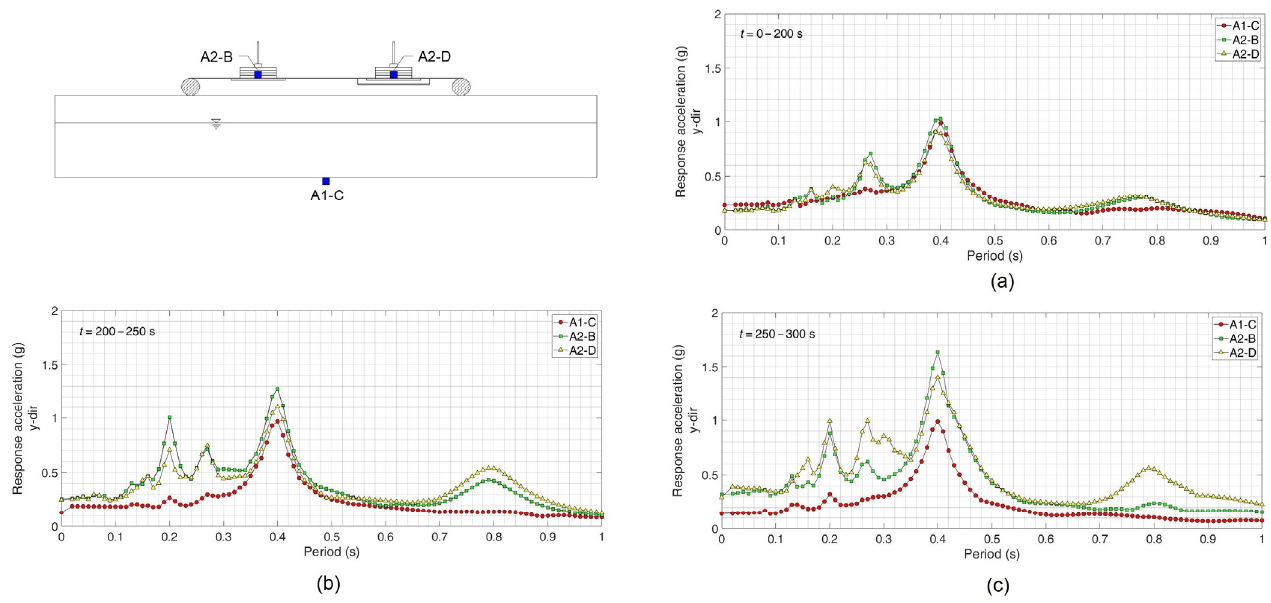
Figure 18. Variation of vertical elastic response spectra: ( a ) t = 0–150 s, ( b ) t = 150–200 s, and ( c ) t = 200–225.